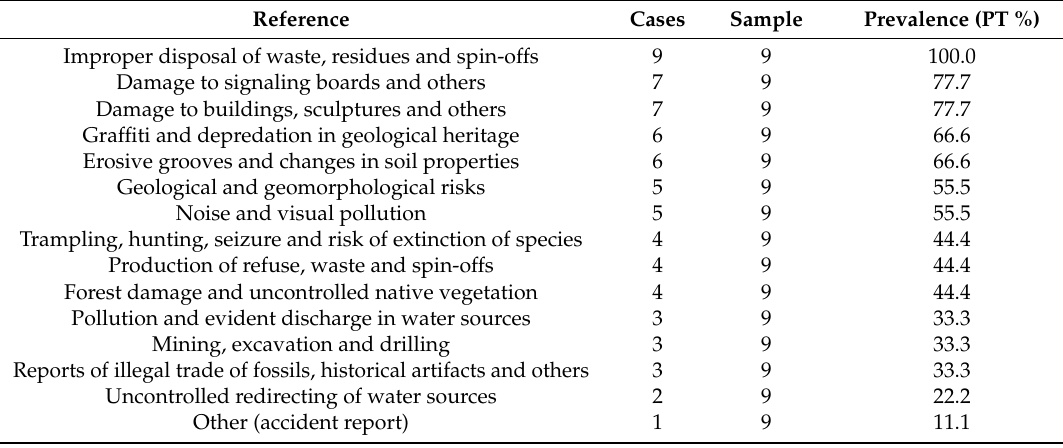
Table 5. Prevalence of evident impacts in Araripe UGGp geosites